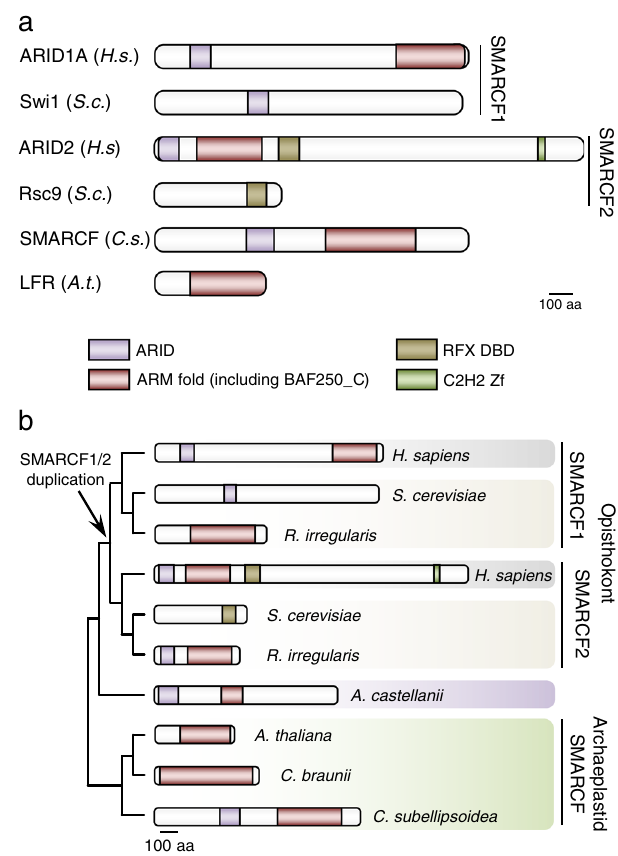
Fig. 2 SMARCF subunits are found in all eukaryotes. a Domain architecture of known SMARCF subunits in H. sapiens , S. cerevisiae , C. subellipsoidea , and A. thaliana . Scale bar, 100 amino acids. b Graphical summary of the evolution of SMARCF domain architectures as predicted from Supplementary Fig. 1. The scale bar indicates the primary sequence length. Phylogram represents the suggested relationship between SMARCF subunits. Arrow indicates the duplication of a single SMARCF into SMARCF1 and SMARCF2 in a fungal and animal common ancestor. Domains are predicted based on Pfam and InterProScan hits, and depicted as colored boxes as indicated in the fi gure. ARM fold represents a series of ARM-fold hits (IPR016024 and IPR00025) and BAF250_C (PF12031/ IPR033388); ARID, AT-rich interaction domain (PF01388/IPR001606); RFX DBD, RFX DNA-binding domain (PF02257/IPR003150); C2H2 Zf, zinc fi nger, C2H2 type (PF00096). H.s . Homo sapiens , S.c .